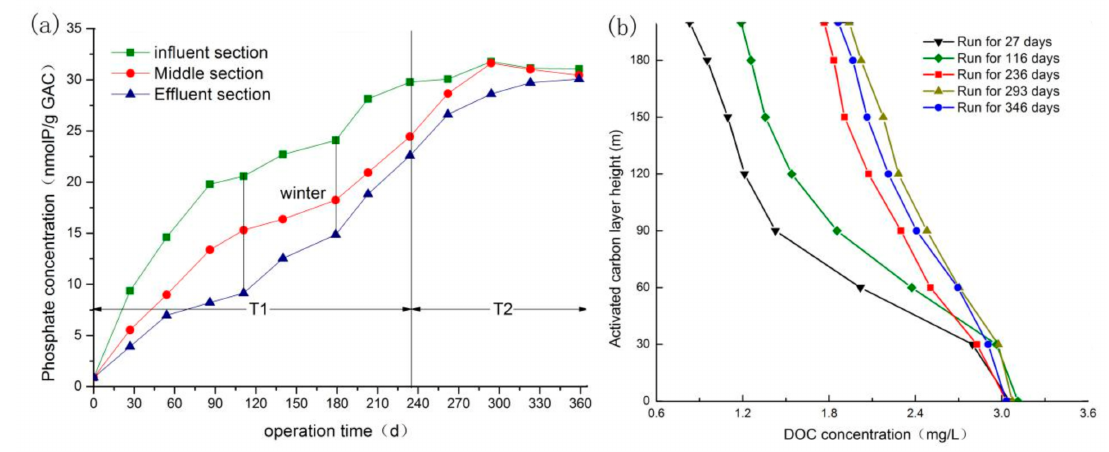
Figure 6. ( a ) Biomass change of carbon surfaces with different carbon depths (GAC 1 = 30 cm, GAC 2 = 90 cm, GAC 3 = 150 cm); ( b ) DOC removal rates in the BAC (27 days, 116 days, 236 days and 346